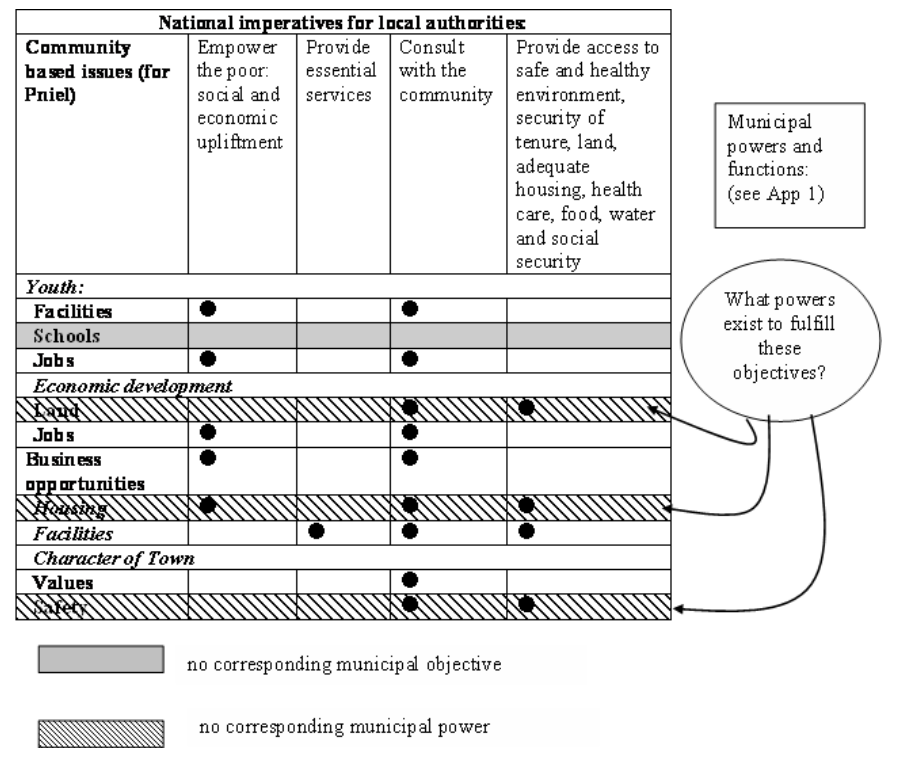
Figure 3: Matrix showing the interaction between community aspirations and local government